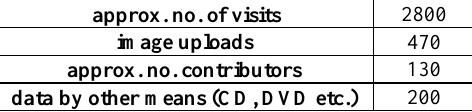
Table 1: Statistical data during the first month.